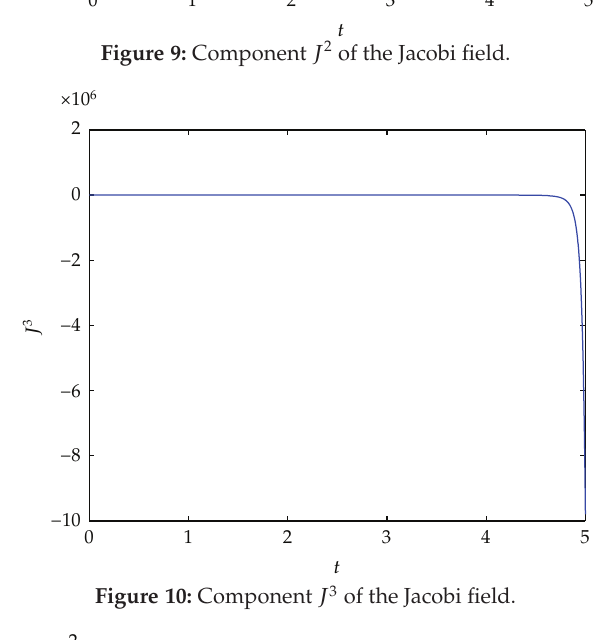
Figure 10: Component J 3 of the Jacobi field.